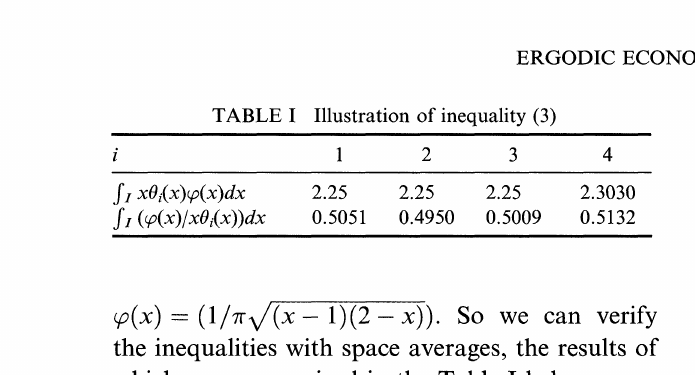
Illustration of inequality (3) 2 3